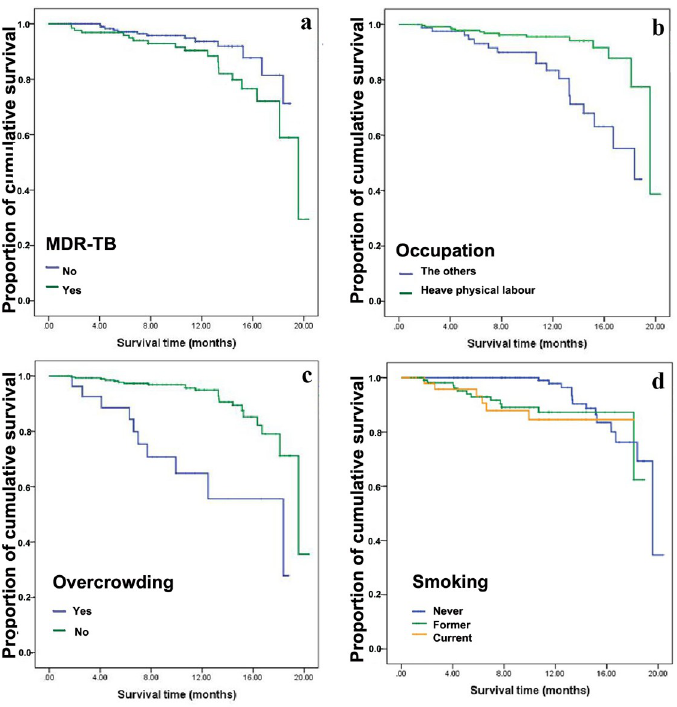
Fig 2. 21-months cumulative probability of survival of patients with TB according to whether overcrowding, whether MDR-TB, occupation and whether smoking in Monrovia, Liberia (2015). a. cumulative probability of survival according to whether MDR-TB, b. cumulative probability of survival according to occupation, c. cumulative probability of survival according to whether overcrowding, d. cumulative probability of survival according to whether smoking.